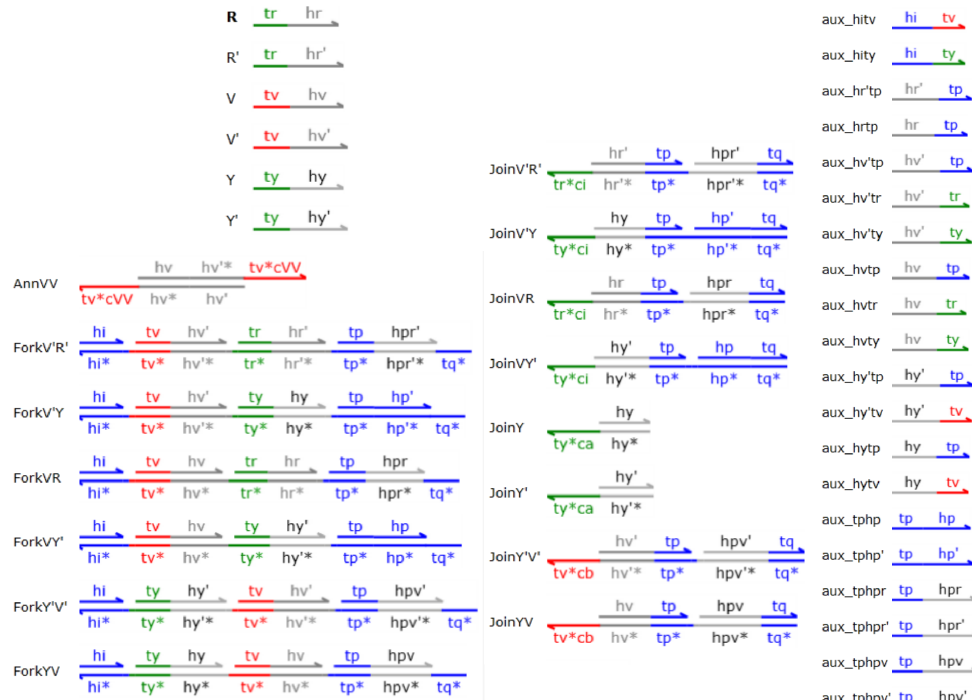
Figure 10. The species that were used to initialise the DSD network for integral feedback control system representation. Here, R, R (cid:48) , V, V (cid:48) , and Y, Y (cid:48) depict the signal strands. Together with the auxiliary strands, they are initialised at high concentrations.